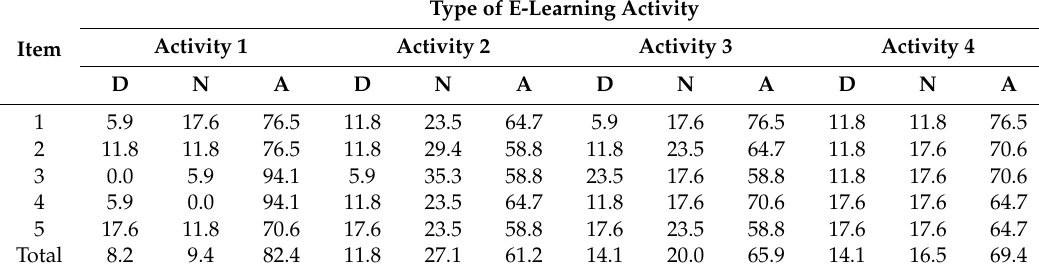
Table 11. Observed answers (D = Disagree, N = Neutral, A = Agree) for items focusing on quality of e-learning activities. Data in % except global punctuation (assessment) in absolute number about a maximum of